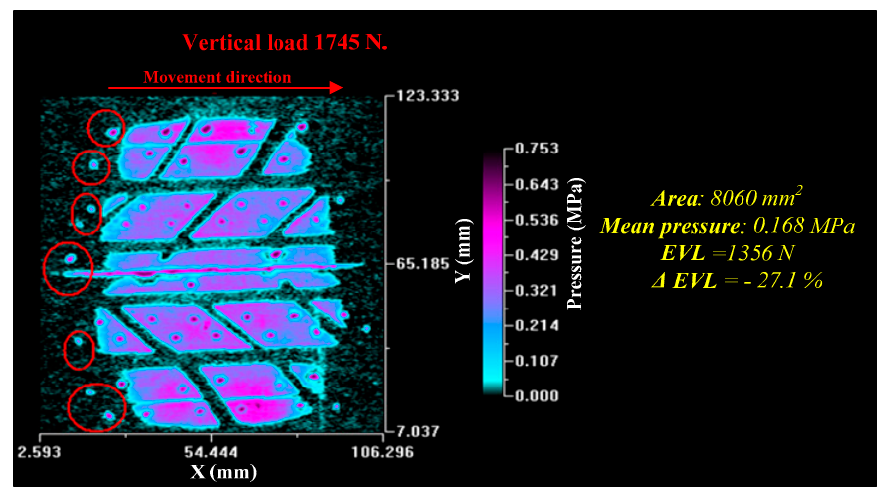
Figure 33. Dynamic tire patch.